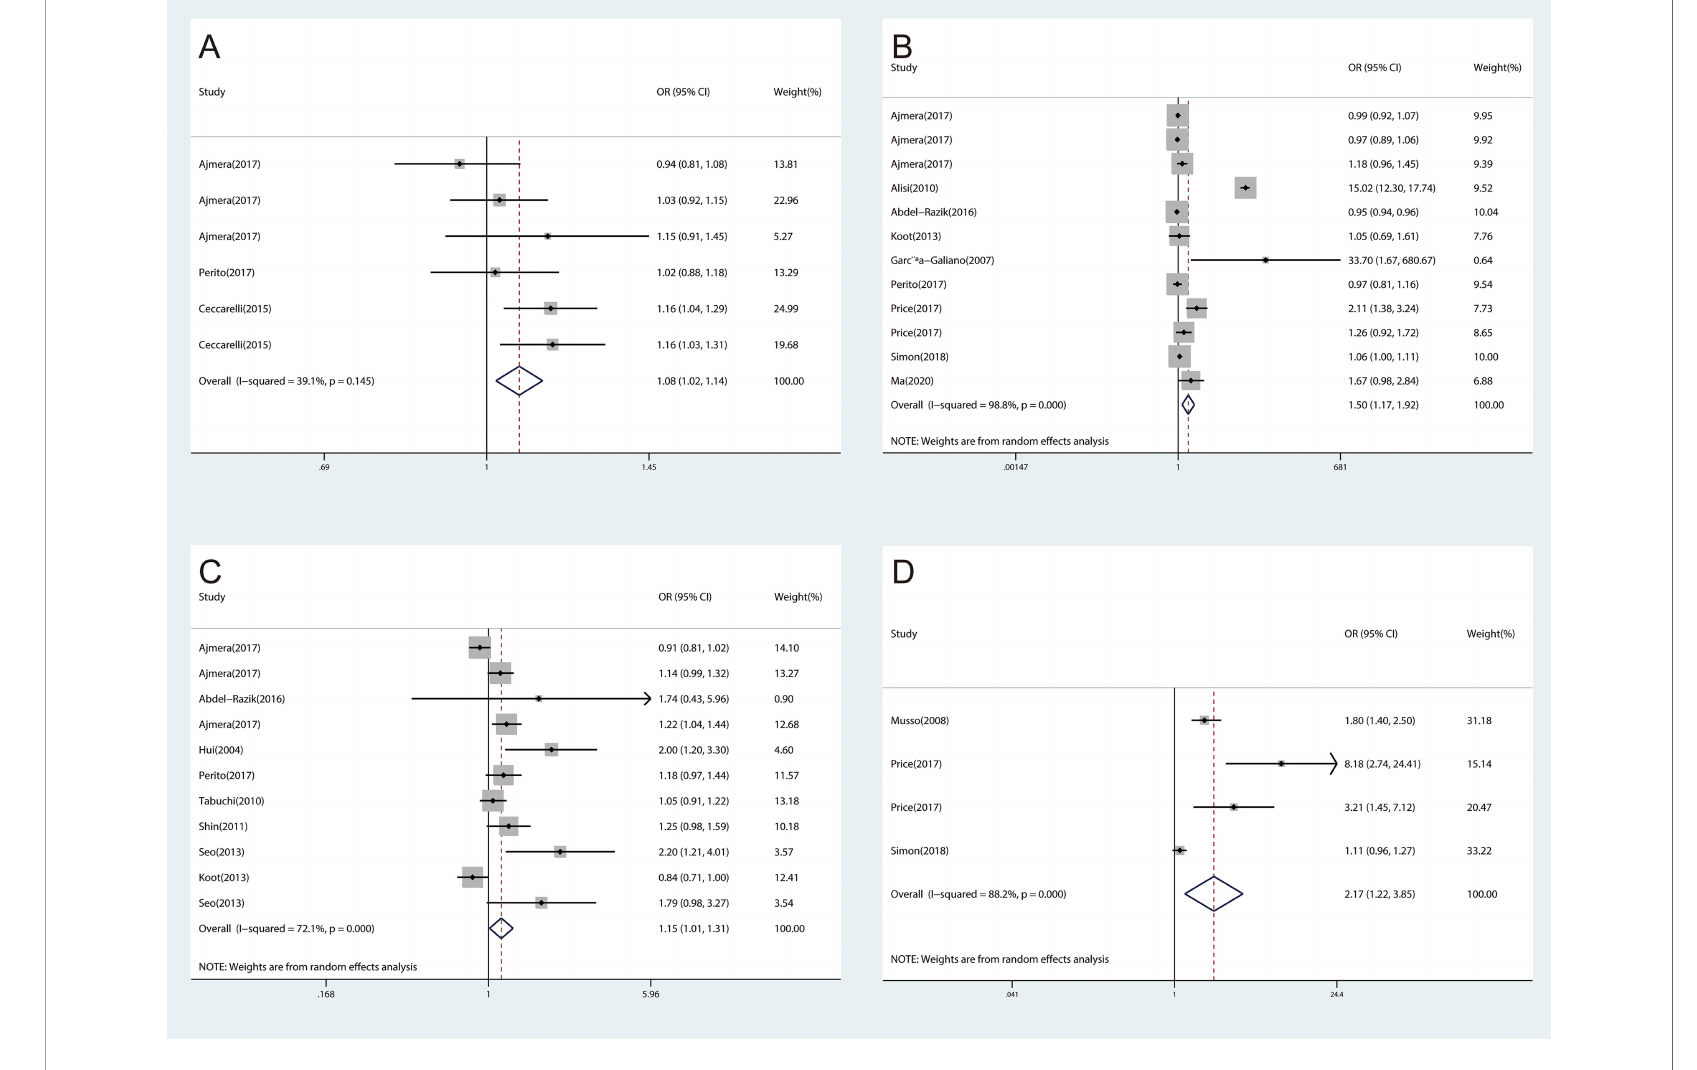
FIGURE 3 | The forest plots of the association between in fl ammatory cytokines and NAFLD. (A) , Association between IL-1 b and NAFLD. (B) , Association between IL-6 and NAFLD. (C) , Association between TNF ‐ a and NAFLD. (D) , Association between ICAM-1 and